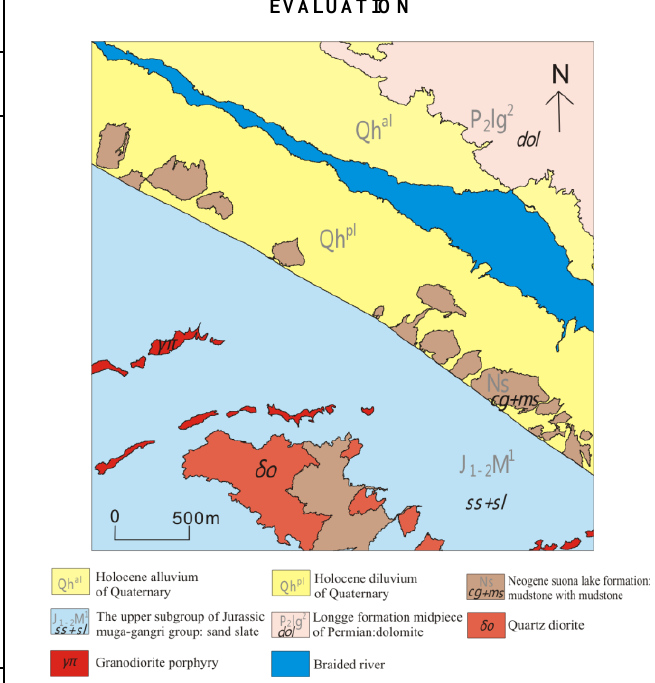
Figure 5 Automatic extraction